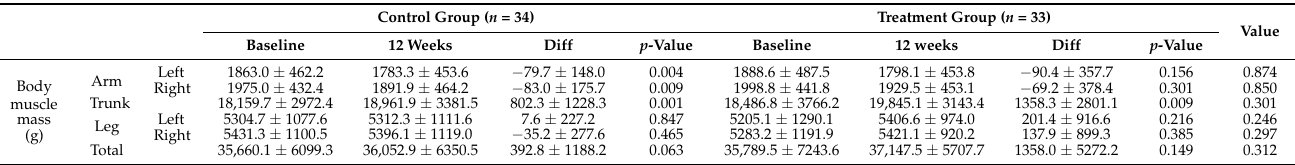
Table 4. Effects of tannase-treated green tea extract on body muscle